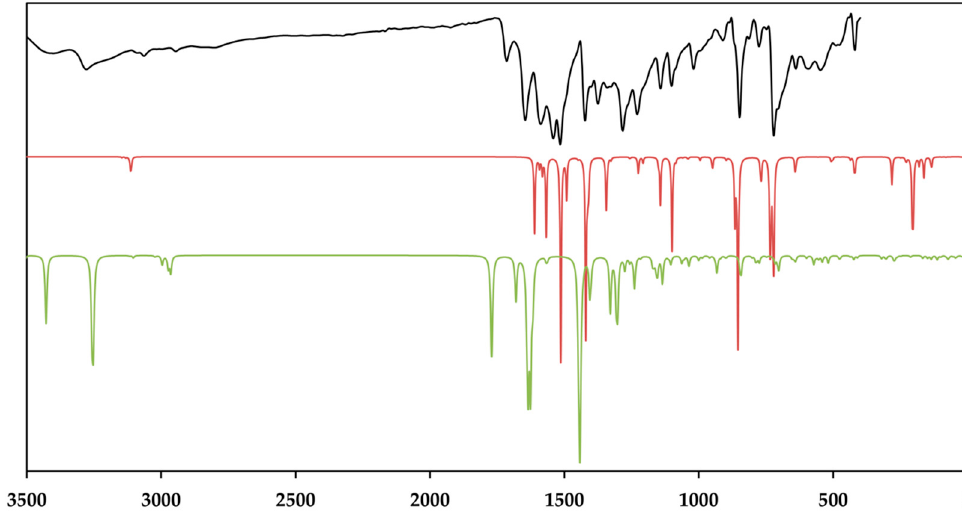
Figure 9. The baseline corrected room temperature FT–MIR spectrum (black) of the crystalline